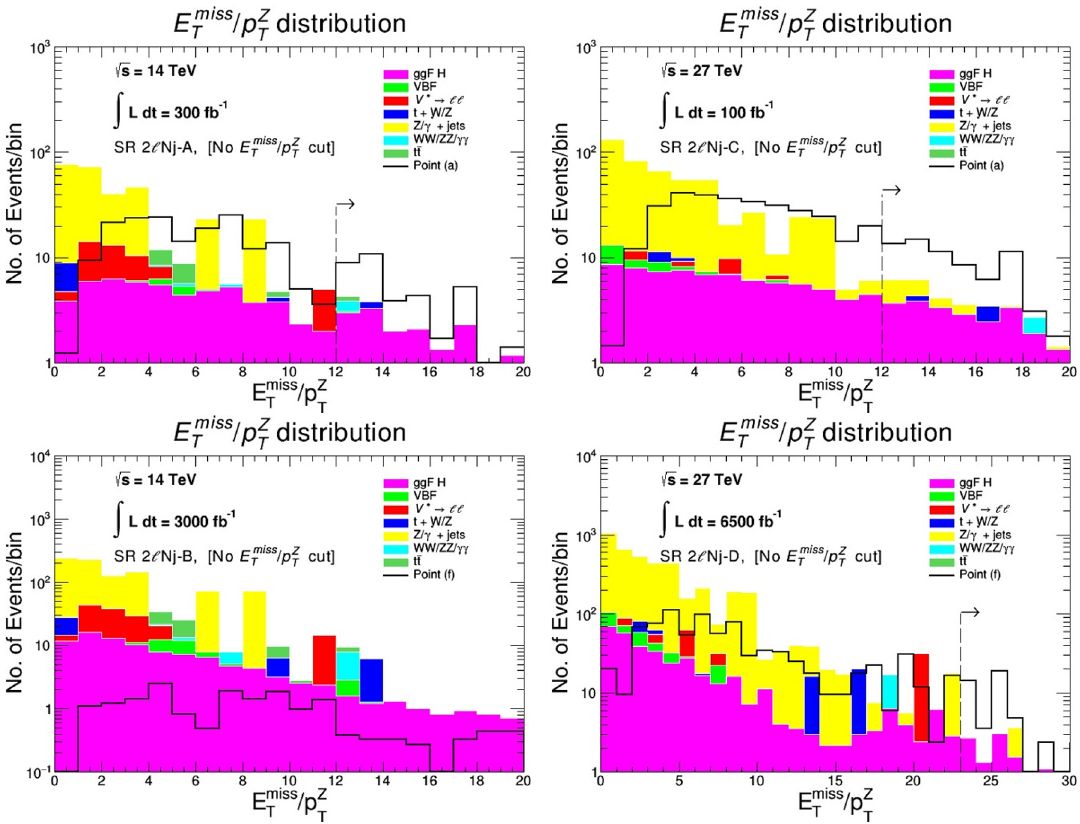
for benchmarks (a) and (f) at 14 TeV (left /p Z T T